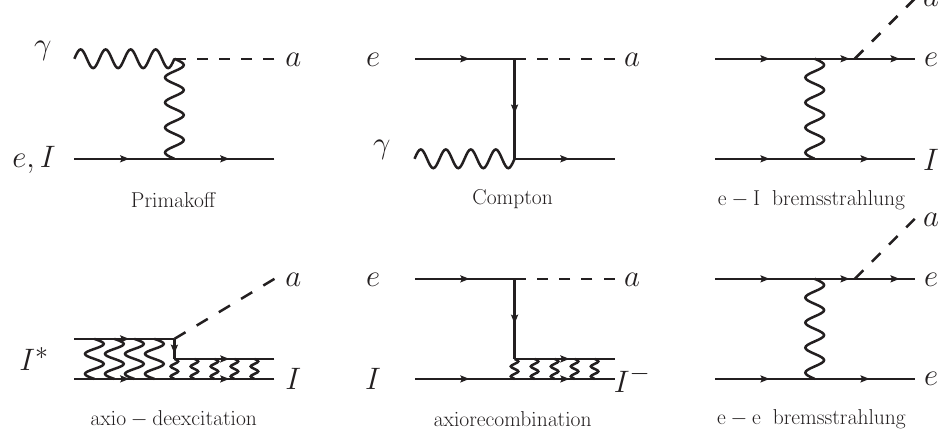
Figure 3: Feynman diagrams of some of the processes producing axions in the stellar interiors. The Primakoff conversion of photons in the electromagnetic fields of the stellar plasma depends on the axion-photon coupling g , and is present is practically a γ every axion model. In non-hadronic models, in which axions couple with electrons at tree level, additional mechanisms are possible, like: atomic axio-recombination and axion-deexcitation, axio-Bremsstrahlung in electron-ion or electron-electron col- lisions and Compton scattering with emission of an axion. Collectively, the flux of solar axions from all these latter g -mediated channels is sometimes called ABC ax- ae ions, from the initials of the mentioned processes. In the diagrams, the letters γ , a , e and I represent a photon, axion, electron and ion respectively. Figure from [ 82 ]